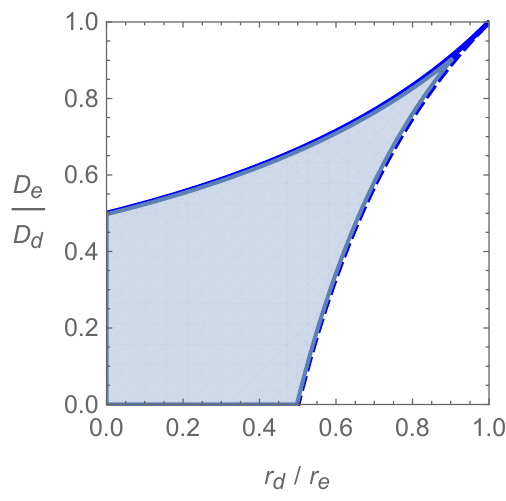
Figure 1. Parameter regions showing when the faster invasion speed observed by the authors of [3] occurs. In the upper left unshaded region the solution travels at the speed at which the establisher travels without competition. In the lower right unshaded region the solution travels at the speed at which the disperser travels without competition. In the shaded region the faster spreading speed is